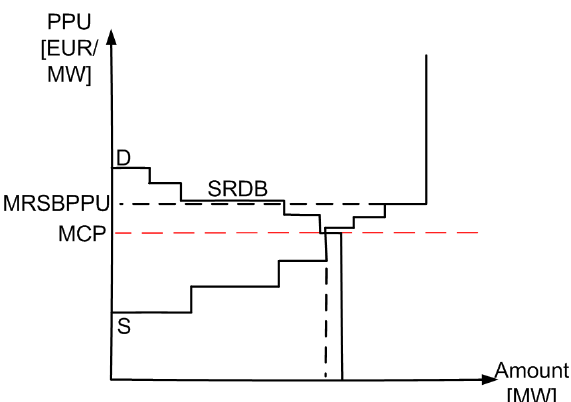
Figure 1. The scheme of the reserve spot market (both in the case of + and − reserve). D —demand, S —supply, MCP —market clearing price, MRSBPPU —Maximal reserve supply bid PPU, SRDB —Supplementary